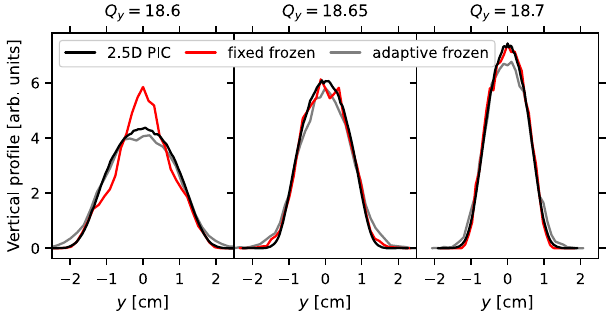
FIG. 20. Vertical beam profiles for three working points above the 2 Q y ¼ 37 resonance, comparing the PIC results (blue curves) to FFSC results (orange curves) after 20 000